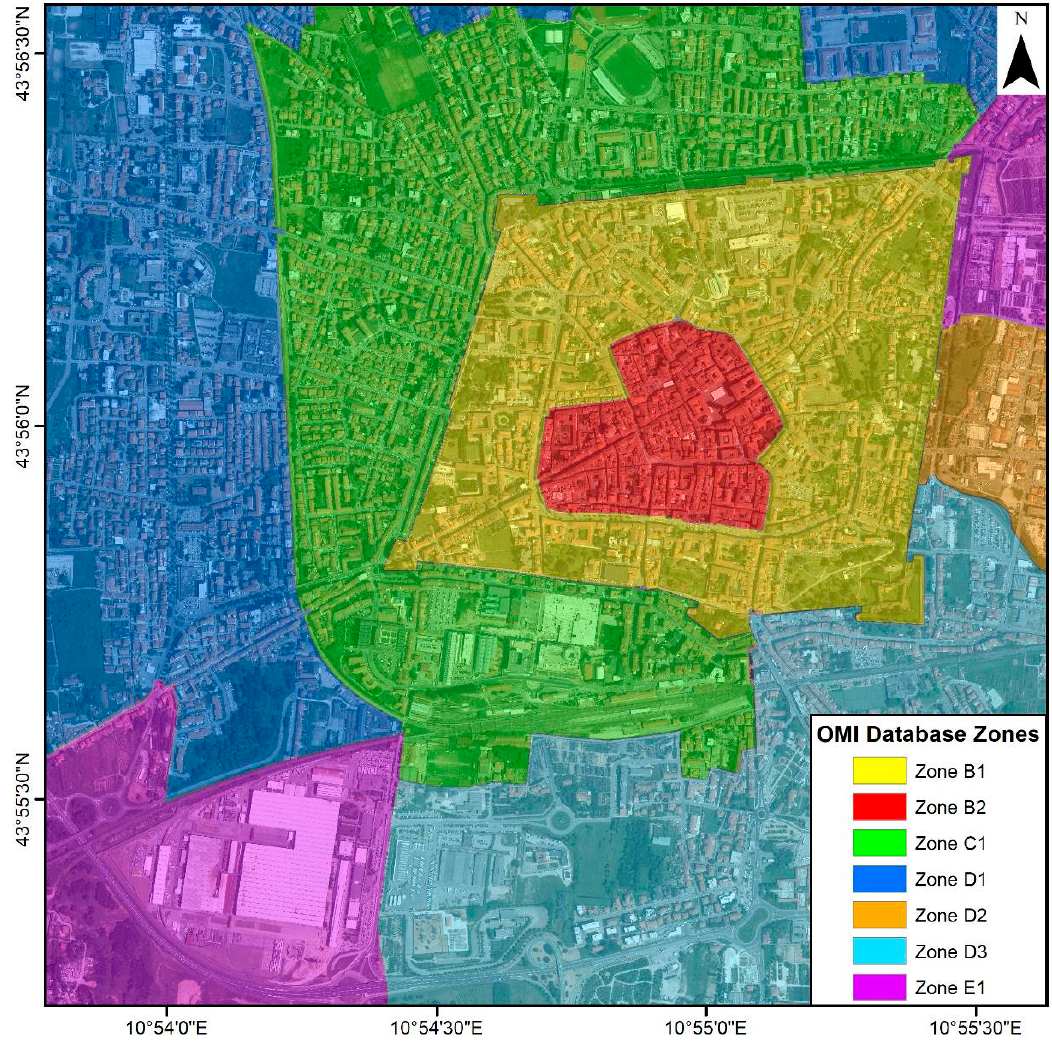
Figure A2. Osservatorio del Mercato Inmobiliario (OMI) database zones used to calculate the market value of the different building types (data from the OMI database—Italian Revenue Agency, 2019).